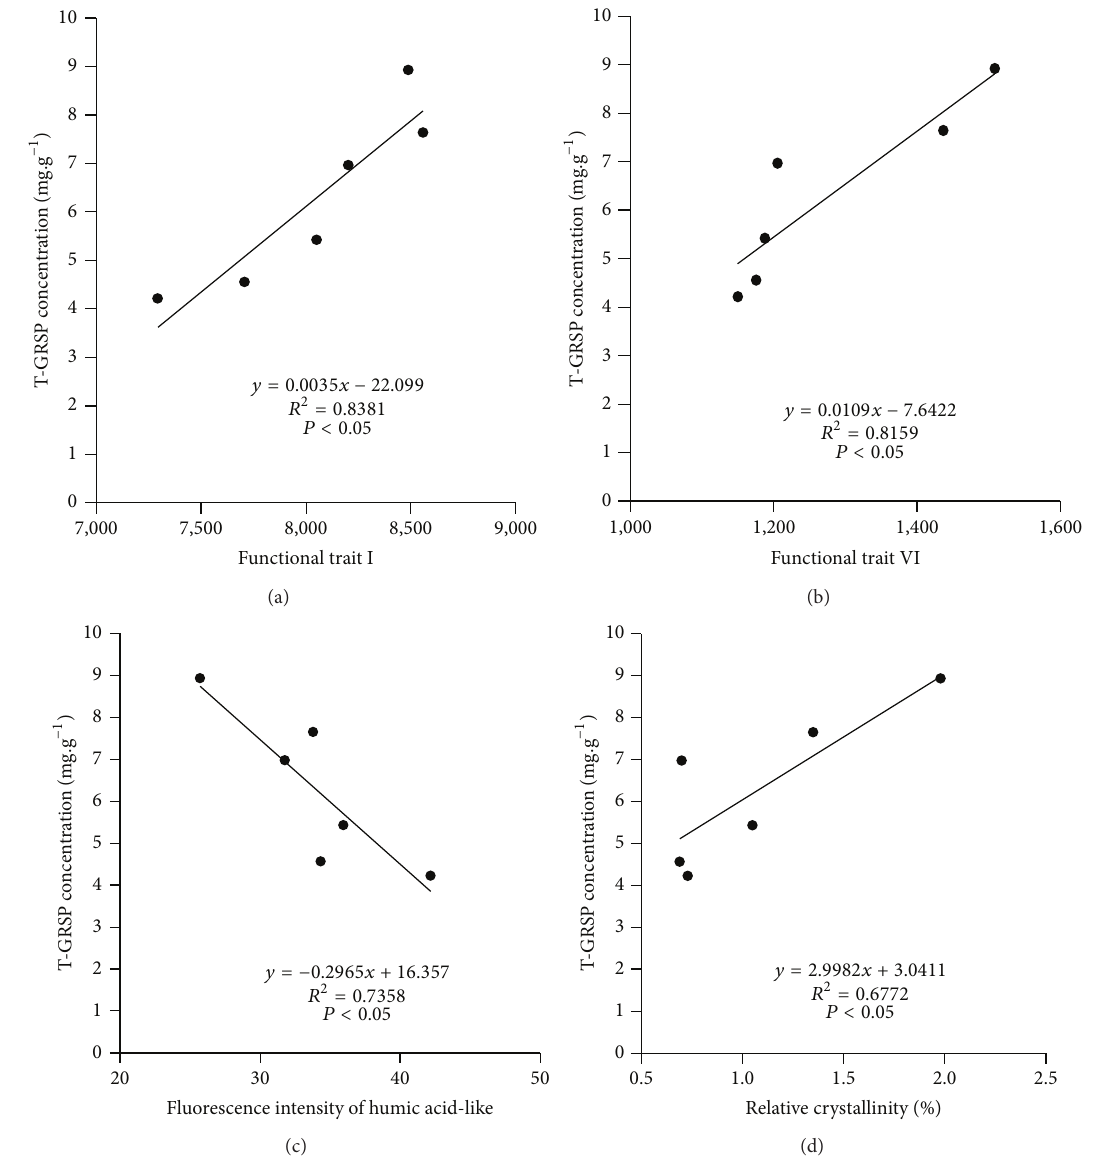
Figure 5: Correlations between T-GRSP concentration and the relative content of functional trait I, VI, fluorescence intensity of humic acid-like, and relative crystallinity. Note: functional traits of I and VI are the same as those in Figure